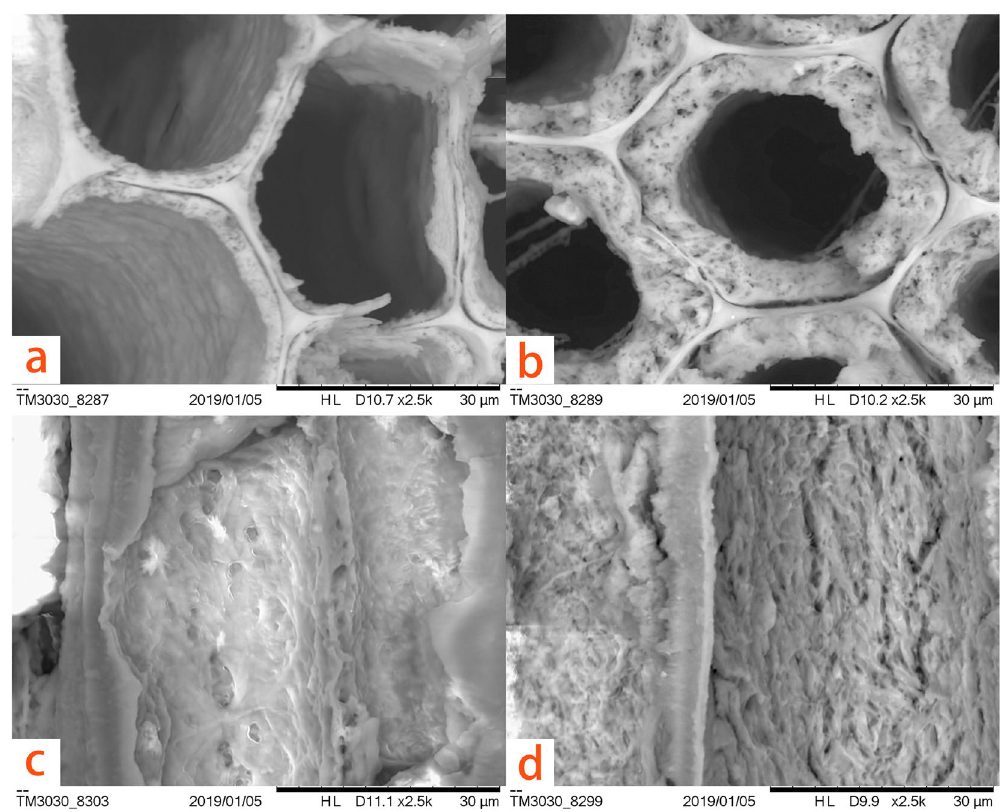
Figure 6. Enlarged SEM micrographs of ( a ) early wood part of the PBMA grafted sample, ( b ) late wood part of the PBMA grafted sample, ( c ) longitudinal section of the untreated sample, ( d ) longitudinal section of the PBMA grafted sample.